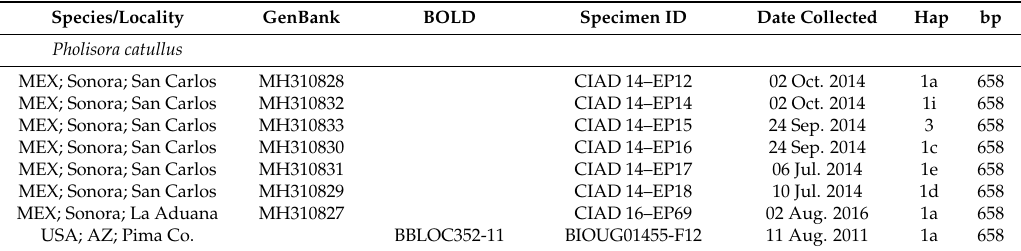
Table 1. GenBank and BOLD COI barcode data for Pholisora catullus , P. mejicanus and Achalarus spp. analyzed in this